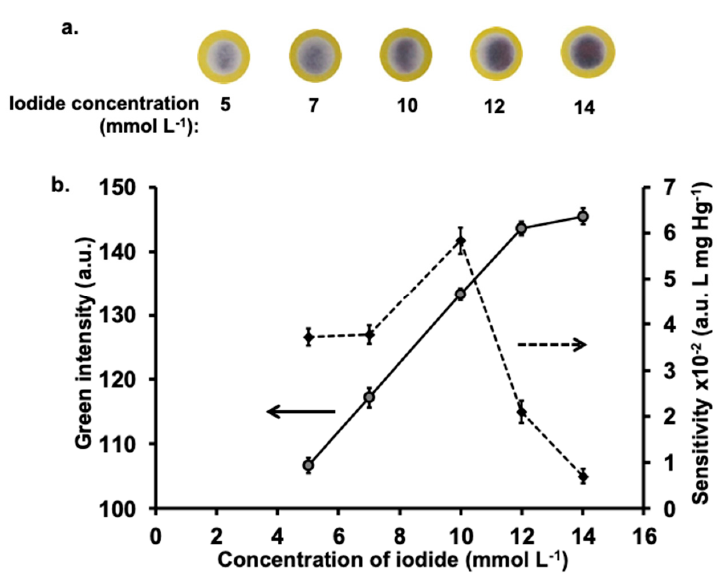
Figure 4. Effect of iodide concentration on analysis of Hg(II): ( a ) images of purple iodine-starch complex for various concentrations of iodide analysis using a standard solution of 150 mg L − 1 Hg and ( b ) plots of effect of iodide concentrations on the green intensity values (left ordinate) using a standard solution of 150 mg L − 1 Hg and sensitivity of Hg(II) analysis (right ordinate). Experimental conditions: 0.2 mol L − 1 KIO 3 in 0.2 mol L − 1 H 2 SO 4 , 10 mmol L − 1 KI, 1% ( w / v ) of starch in 0.1 mmol L − 1 KI and reaction time of 4 min .